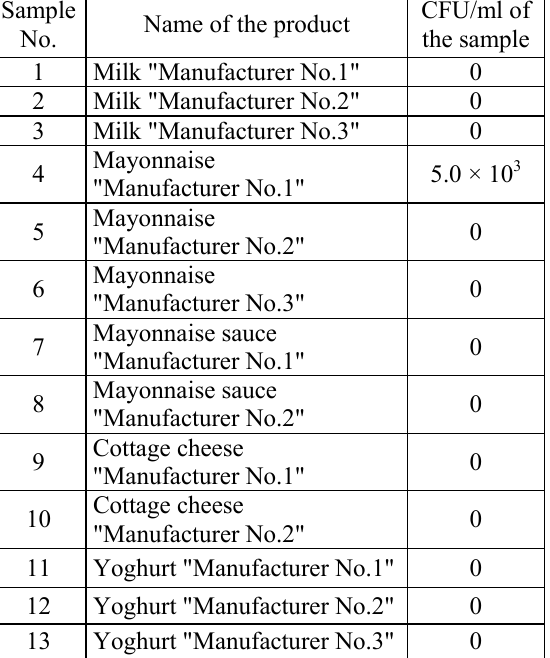
Table 4. Number of microorganisms from the studied products in the Saburo nutrient medium contaminated with yeast and filamentous fungi Sample